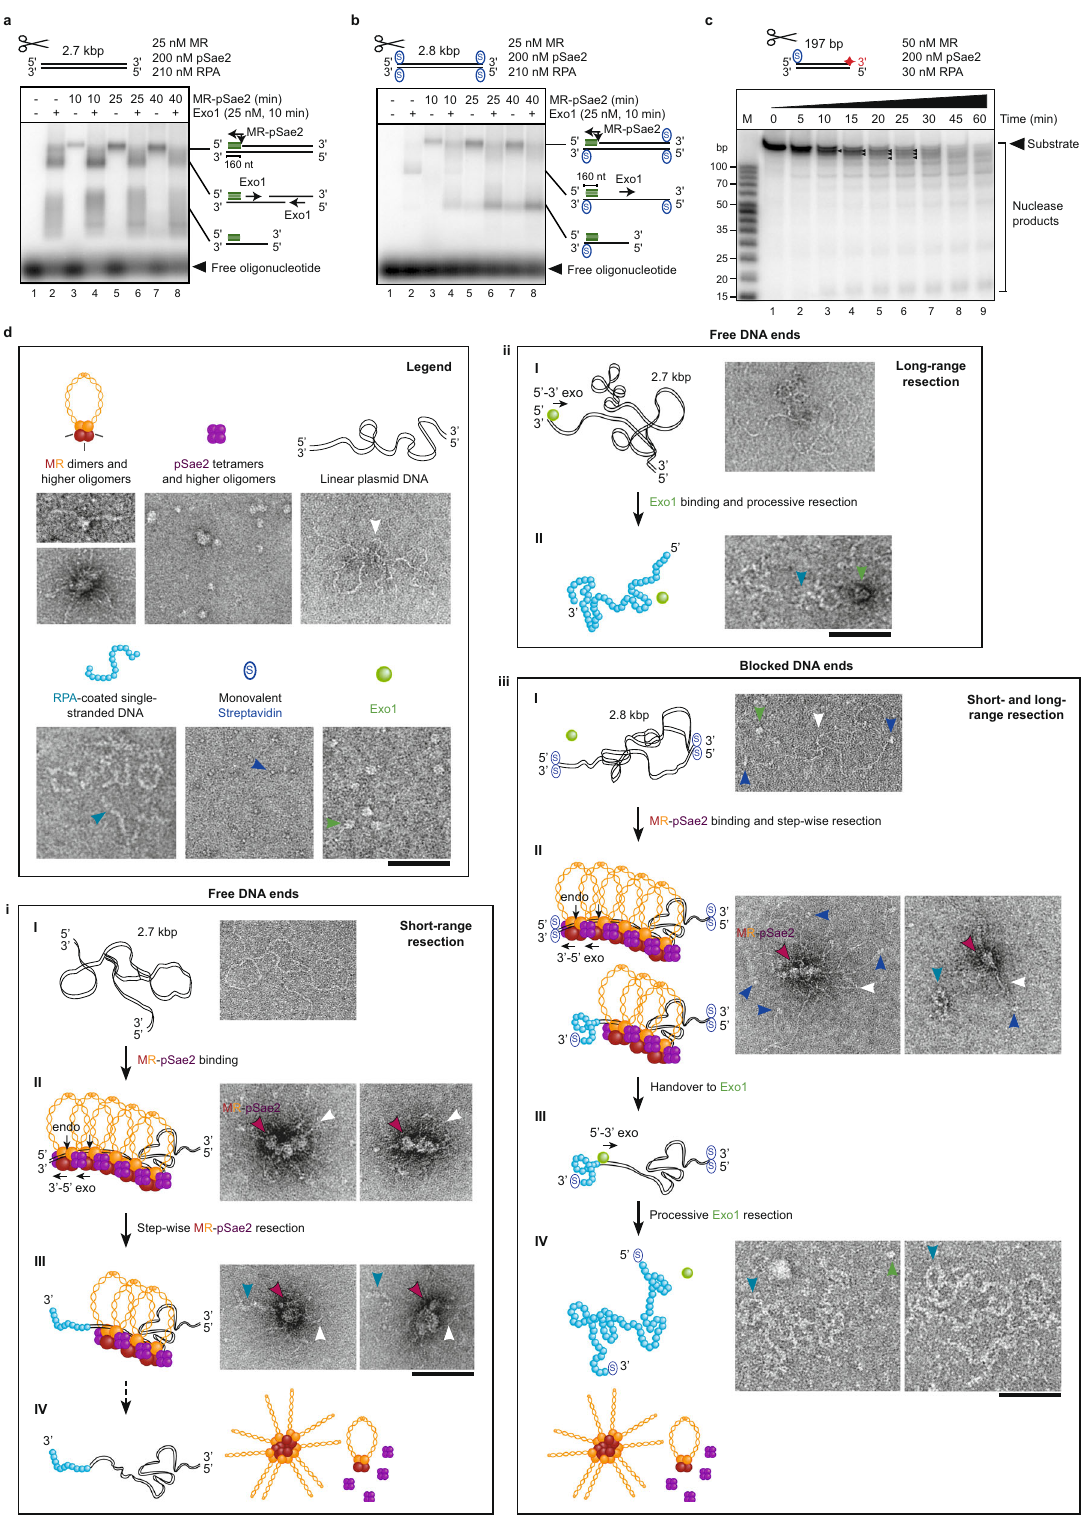
assays demonstrate that Exo1 requires MR-pSae2-dependent short-range resection at protein-blocked DNA ends to initiate long-range